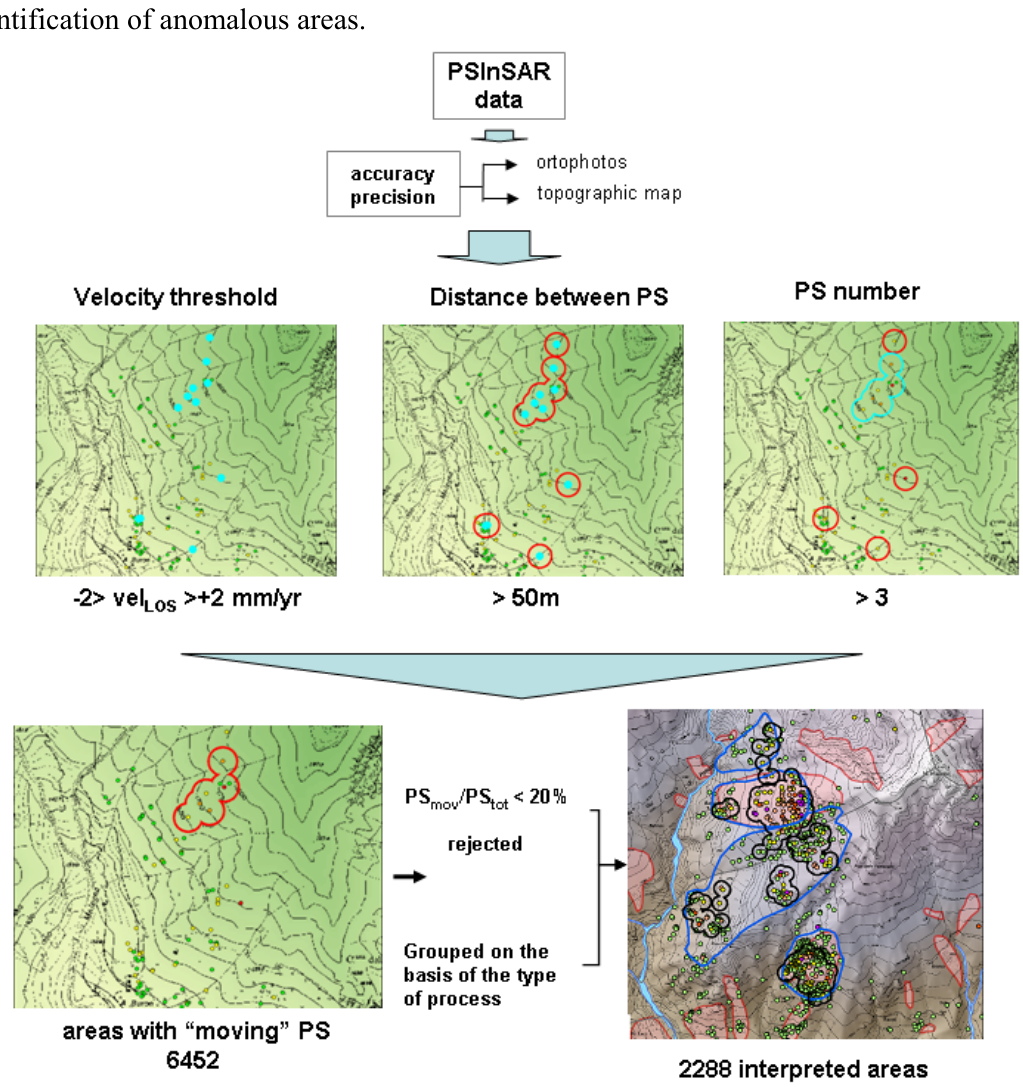
Figure 3. 1 st step of the methodology used for the PS geological interpretation: identification of anomalous